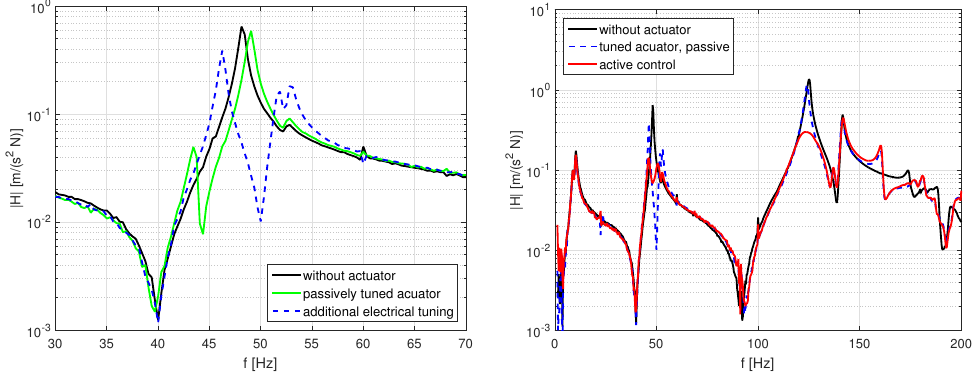
Figure 14. Tuning of the adaptive absorber to the first elastic mode of the truss and control